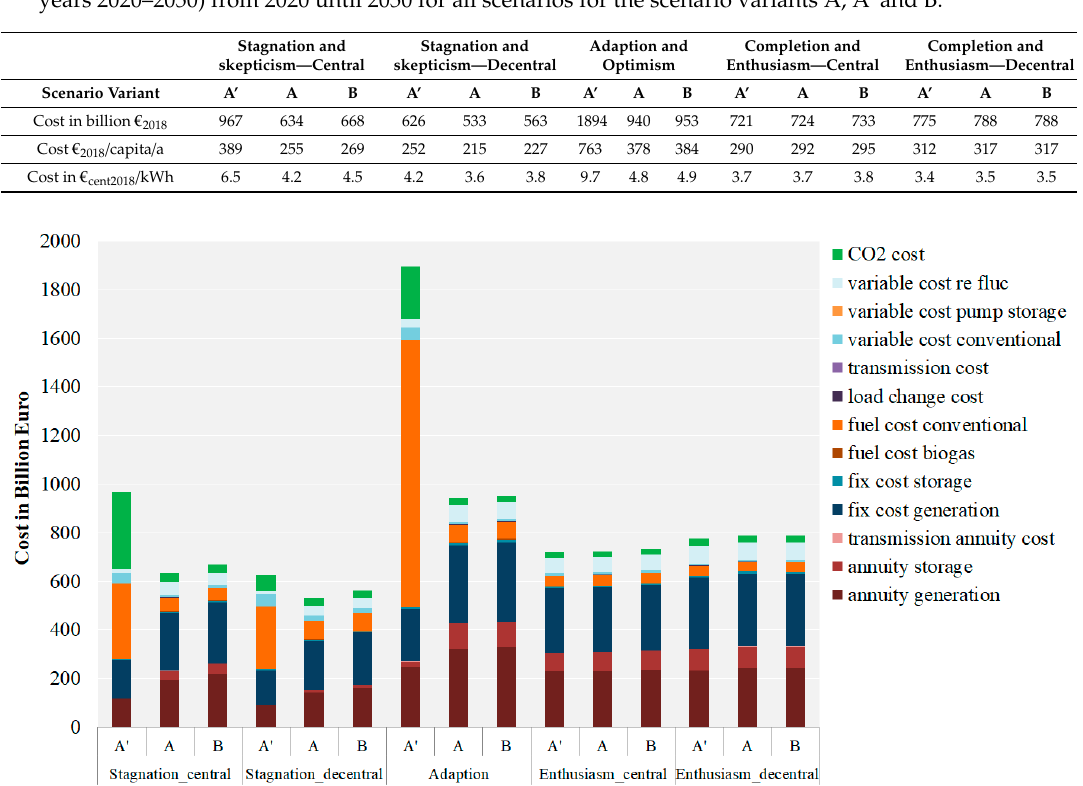
Figure 4. Cumulated total system cost by cost component, scenario, and variant (A’, A and B).